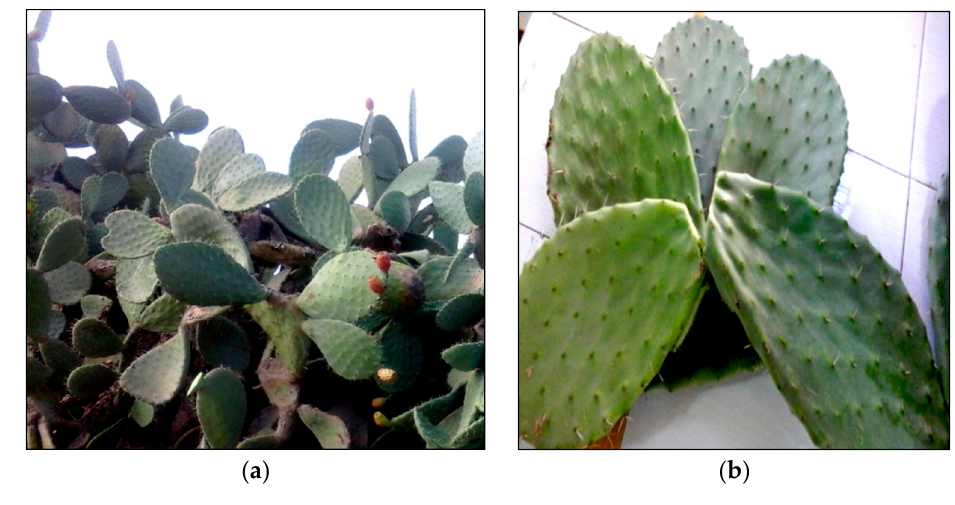
Figure 1. Cactus field ( a ) and the cladodes or pads ( b ) .